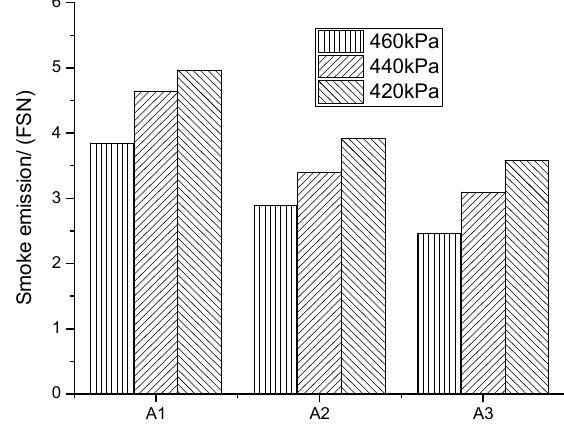
Figure 7. Smoke emission for different combustion chambers.